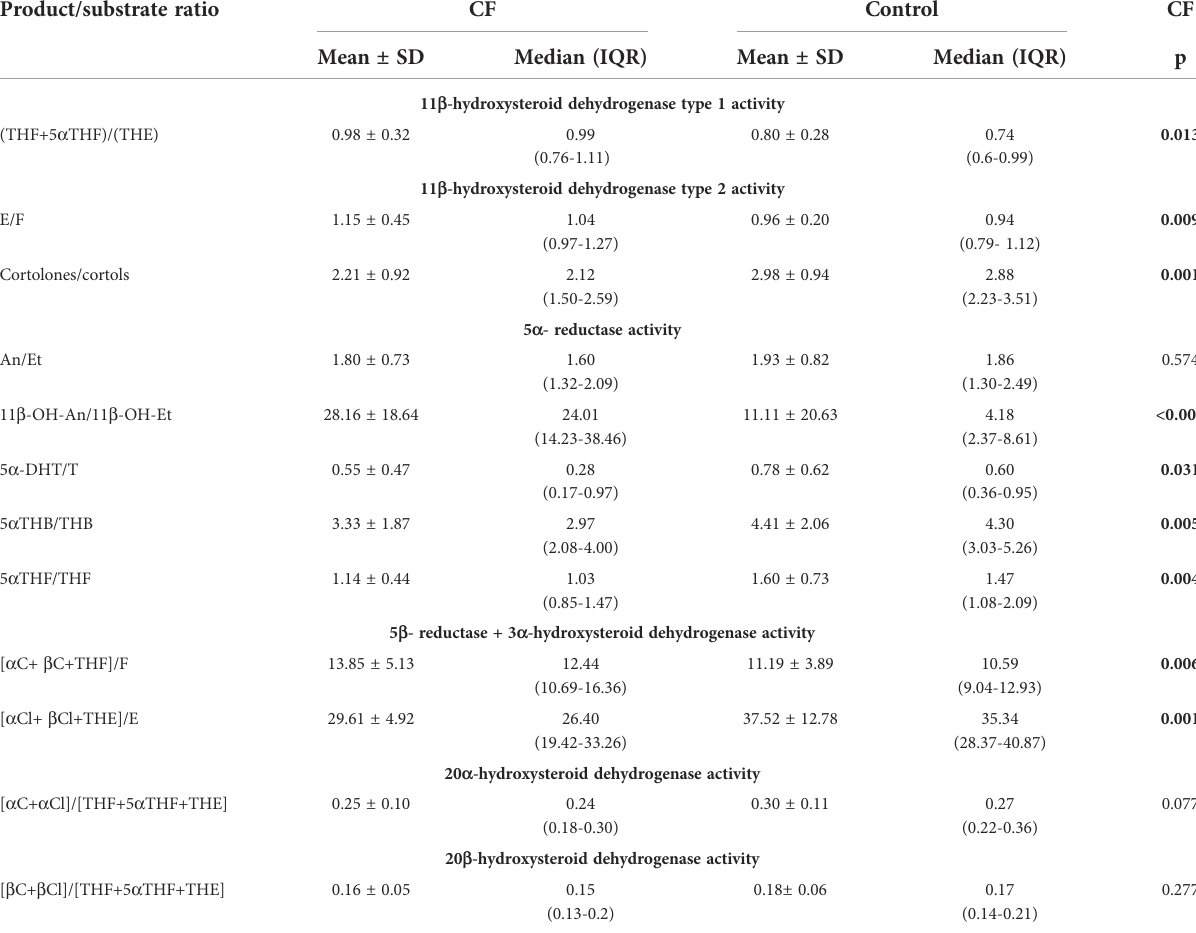
TABLE 3 Enzymes activity calculated from the product/substrate ratios and comparison between CF children and adolescents and healthy control. Product/substrate